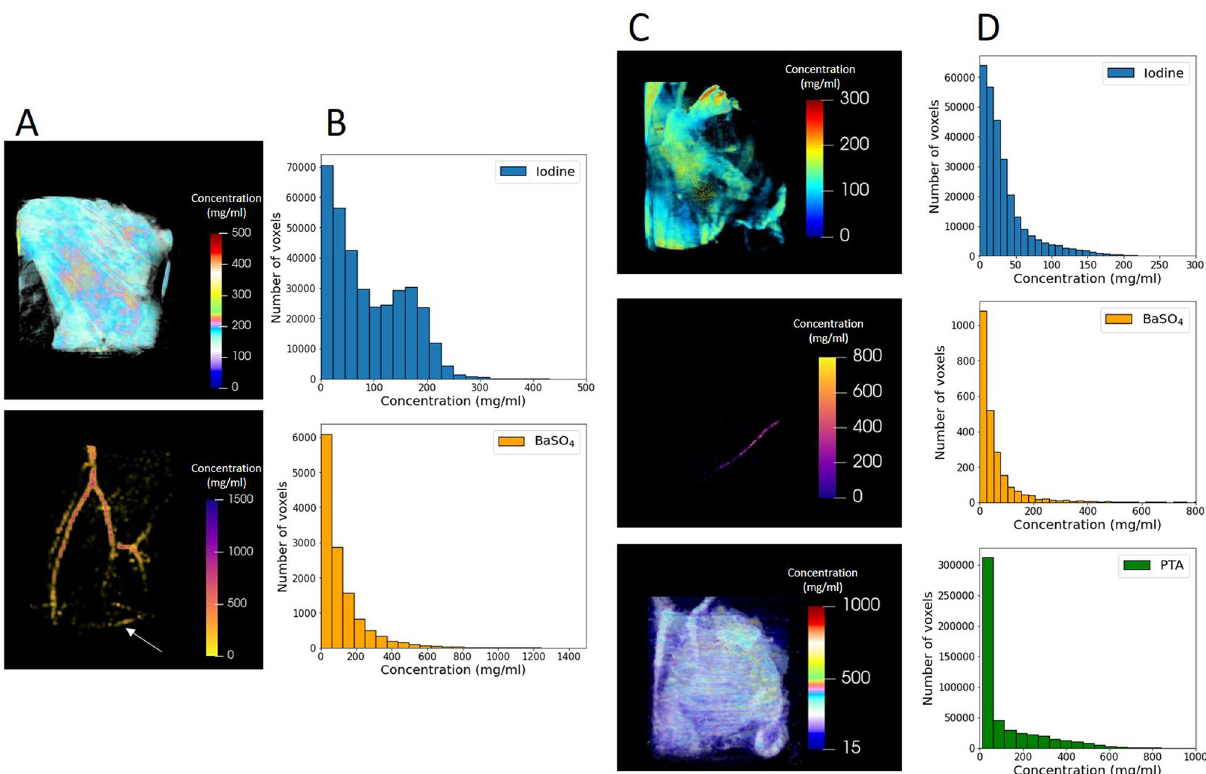
Figure 6. Distribution and concentration of contrast agents. ( A ) 3D volume maps quantifying the stain distribution of iodine (top) and barium (bottom) in the soft tissue and blood vessels respectively within the double-stained mouse hindlimb. Some low concentrations regions (white arrow) with a systematic pattern of voxels are attributed to ring artefacts or general noise. ( B ) Histogram detailing the statistical breakdown of concentration distribution on a voxel-by-voxel basis for each chemical stain of the sample in ( A ). ( C ) Volume maps for the triple-stained mouse forelimb, showing absolute concentration values in each voxel for iodine (top), BaSO 4 (middle) and PTA (bottom). ( D ) Concentration distribution histogram for each stain within the sample in ( C